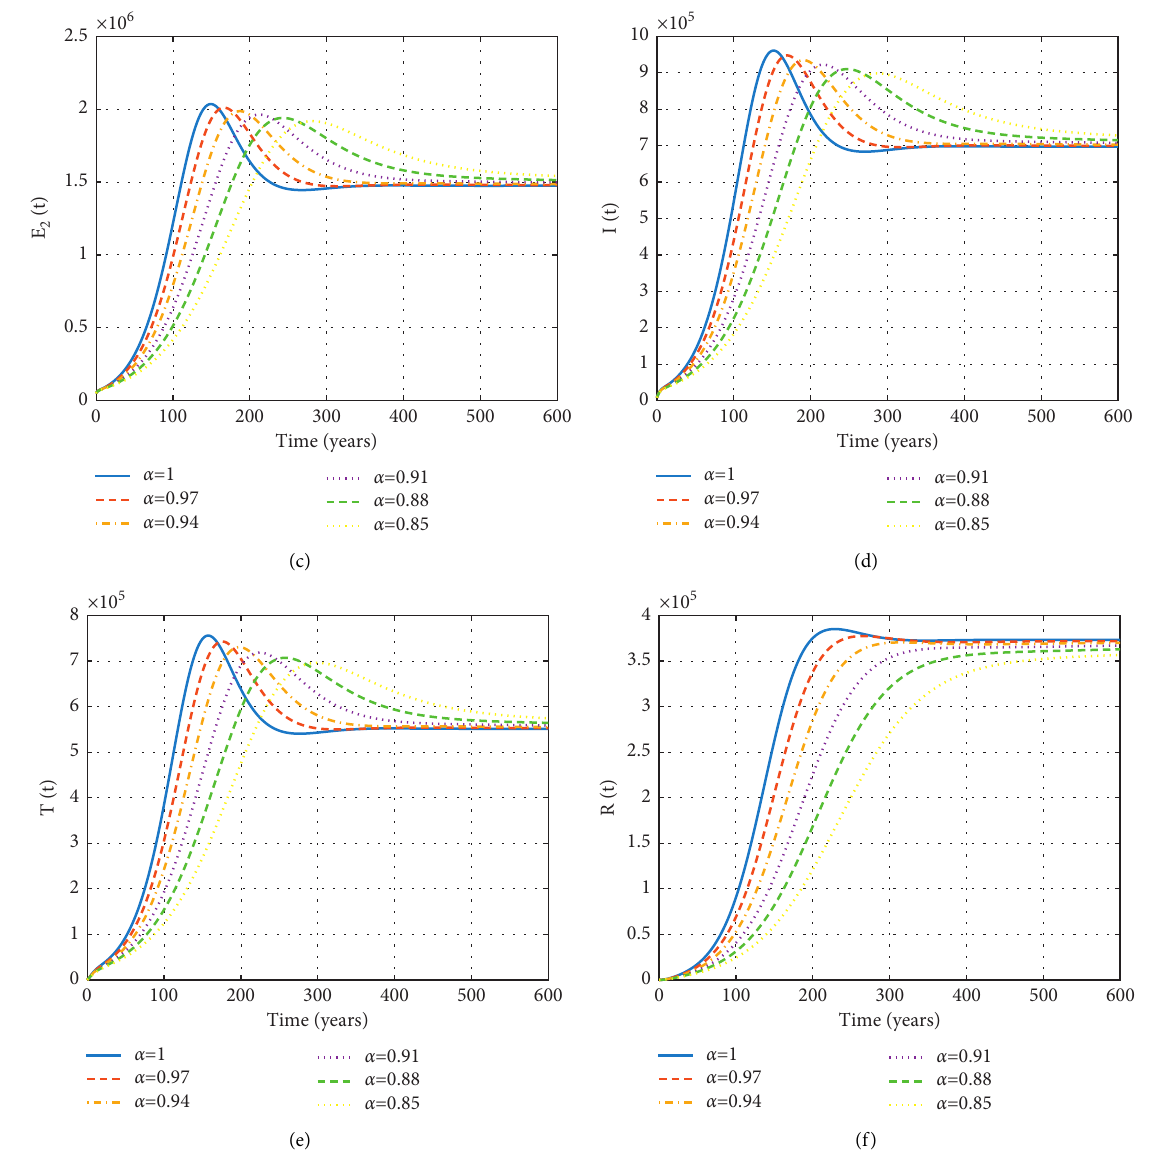
Figure 3: Numerical results of model (7) for different fractional orders α